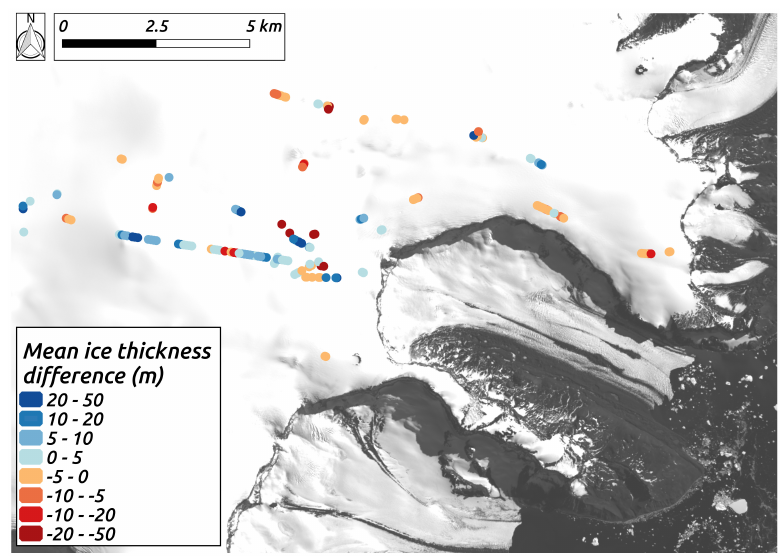
Figure 8. Mean ice thickness difference between 2018 and 1995–1998 within a search radius of 50m. Background image: Landsat-8 (20 February 2017, courtesy of the U.S. Geological